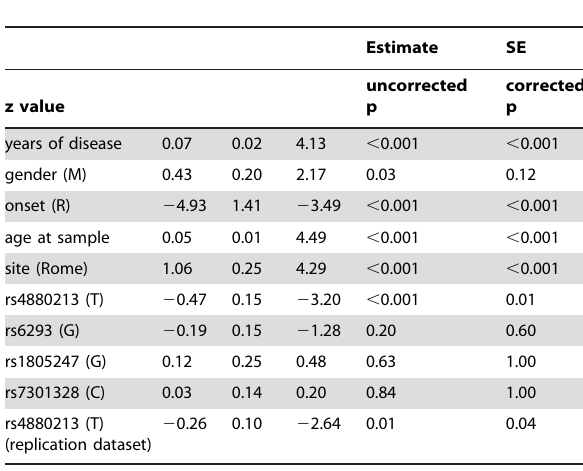
Table 2. Logistic regression (dichotomous EDSS as response variable, 0 if EDSS ,